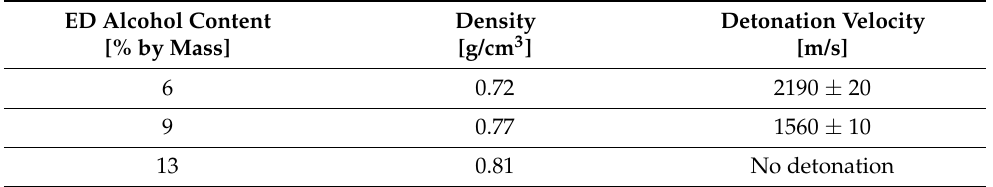
Table 5. Dependence of detonation velocity of tested mixtures on ethan–1, 2–diol (ED) alcohol content.